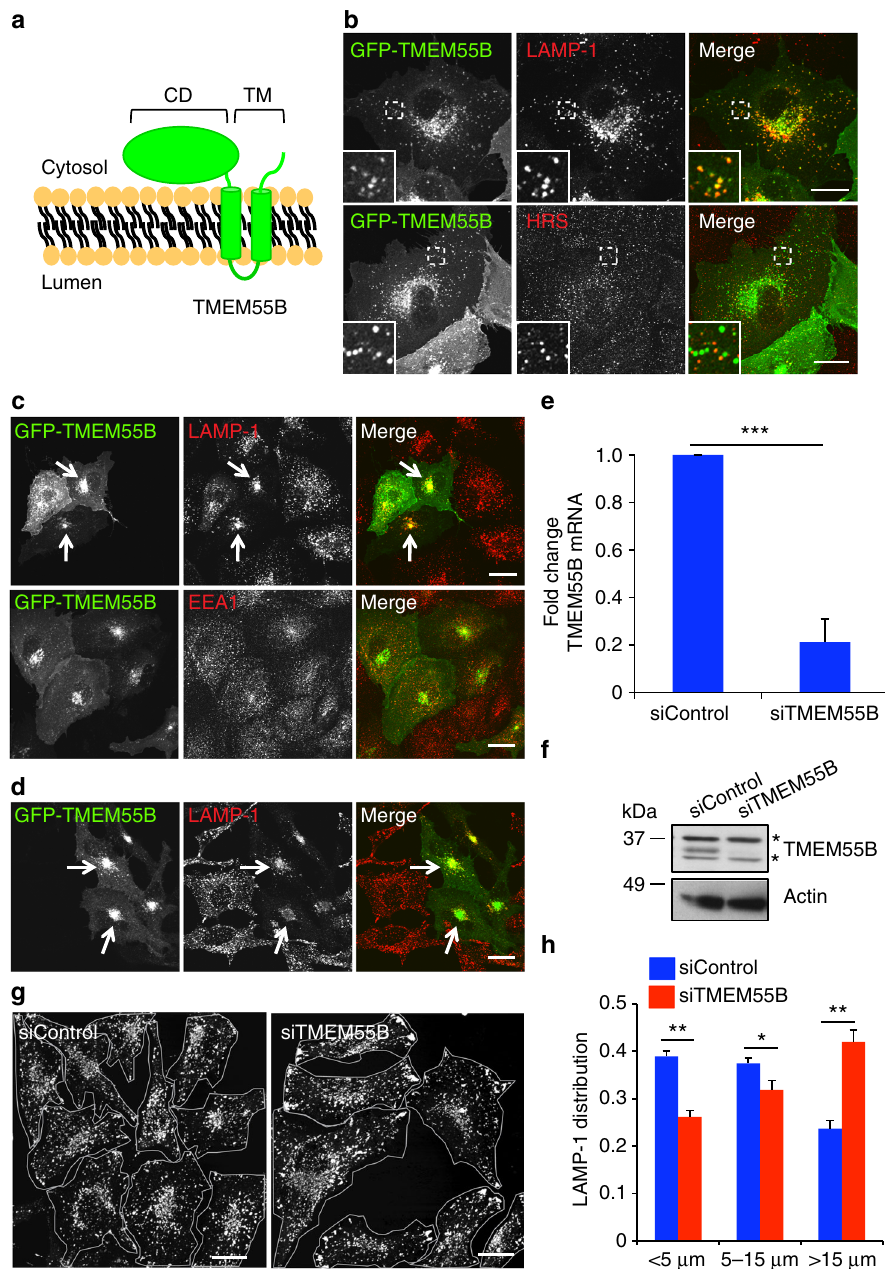
Fig. 1 TMEM55B regulates lysosomal positioning. a Schematic of the predicted membrane topology of TMEM55B. b ARPE-19 cells transfected with GFP- TMEM55B for 18 h. Cells were fi xed, permeabilized, and immunostained with antibodies against LAMP-1 (top) or HRS (bottom). Insets represent a 3.2- (top) and 4.5- (bottom) fold magni fi cation of the indicated areas. c ARPE-19 cells infected with adenovirus expressing GFP-TMEM55B for 30 h. Cells were fi xed, permeabilized, and immunostained with antibodies against LAMP-1 (top) or EEA1 (bottom). Arrows denote bulk of lysosomal accumulation. d HeLa cells infected with adenovirus expressing GFP-TMEM55B for 30 h. Cells were fi xed permeabilized and immunostained with antibodies against LAMP-1. Arrows denote bulk of lysosomal accumulation. e , f HeLa cells treated with TMEM55B or Control siRNAs for 6 days. e Relative quantitative real-time PCR analysis of TMEM55B mRNA transcript levels (mean ± s.e.m. of the RNA fold change of indicated TMEM55B normalized to actin mRNA from three independent experiments; ∗∗∗ P < 0.0001). f Immunoblot of lysates of cells treated with TMEM55B or Control siRNA. g HeLa cells treated with TMEM55B or Control siRNA were immunostained with antibody against LAMP-1. h Quanti fi cation of lysosome distribution, percentage of total fl uorescence signal detected at 0 – 5 μ m, 5 – 15 μ m, or > 15 μ m from nuclear rim. Quanti fi ed results are presented as mean ± s.e.m. using two-tailed t -test ∗ P < 0.05, ∗∗ P < 0.005 were considered signi fi cant, n ≥ 30 from three or more independent experiments. Scale bars, 20 μ